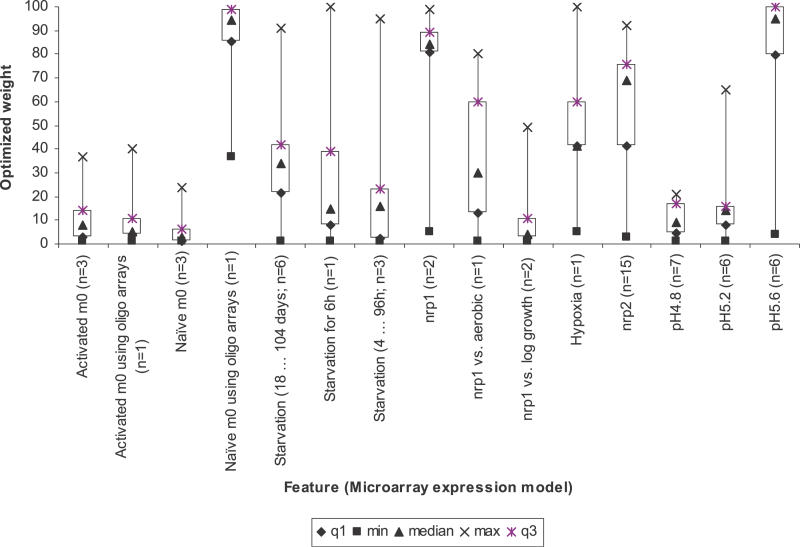
Box and Whisker Plots of GA-Optimized Weights from 100 Evolved SolutionsEach possible solution was able to rank eight of ten target genes within the top 25%.M0, macrophage; n, number of experiments; nrp, nonreplicating persistence.